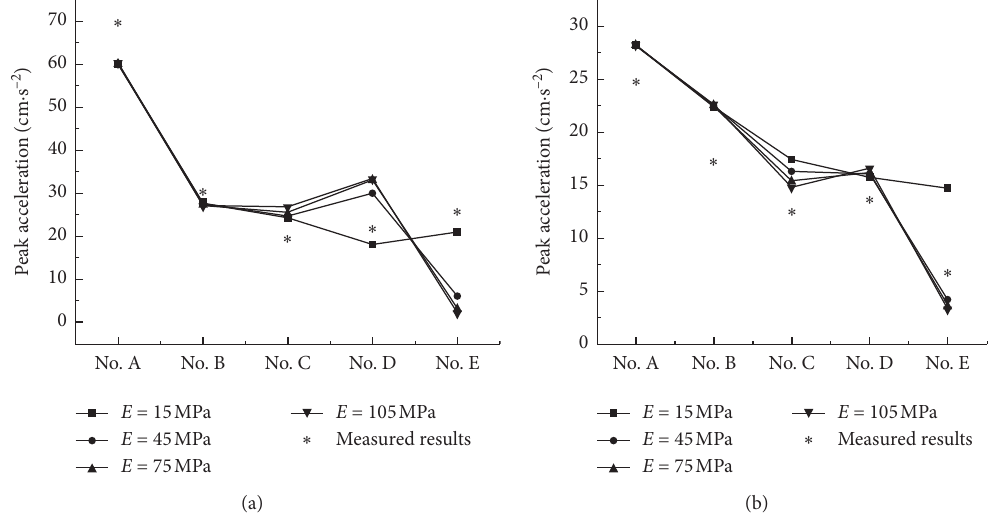
Figure 18: Influence of the elastic modulus of the fifth terrace on vibration. (a) Horizontal direction. (b) Vertical